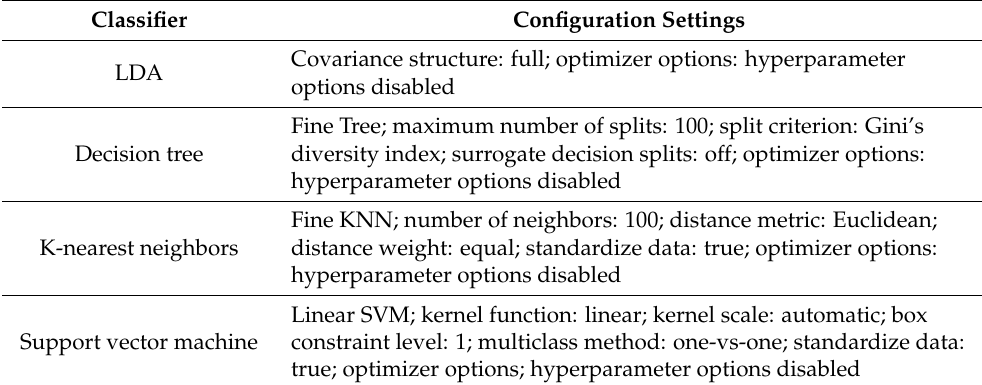
Table 4. Configuration settings for each